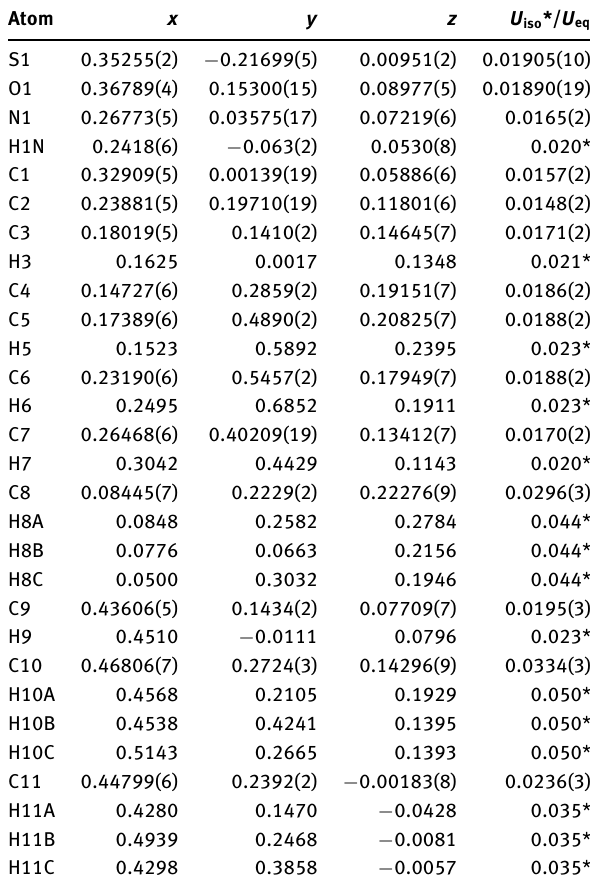
Table 2: Fractional atomic coordinates and isotropic or equivalent isotropic displacement parameters (Å 2